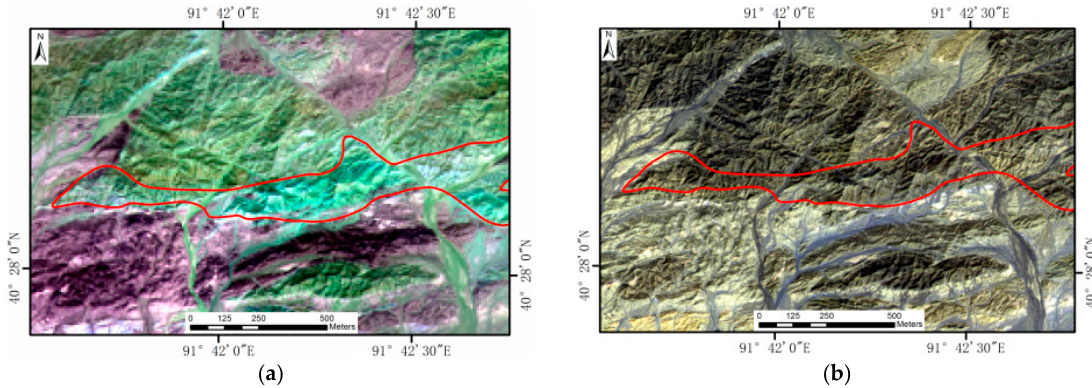
Figure 4. The area delineated by red line was a newly discovered lithological unit. ( a ) The newly discovered lithological unit in WV-3 SWIR image before resampling (R: Band 16, G: Band 13, B: Band 11); and ( b ) the newly discovered lithological unit in WV-3 VNIR image (R: Band 8, G: Band 5, B: Band